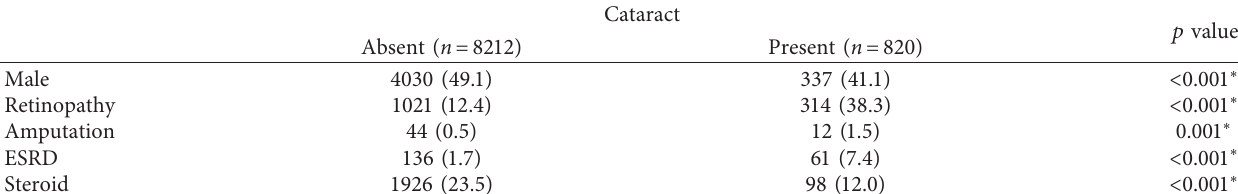
Table 4: The distribution of associated factors according the presence of cataracts.